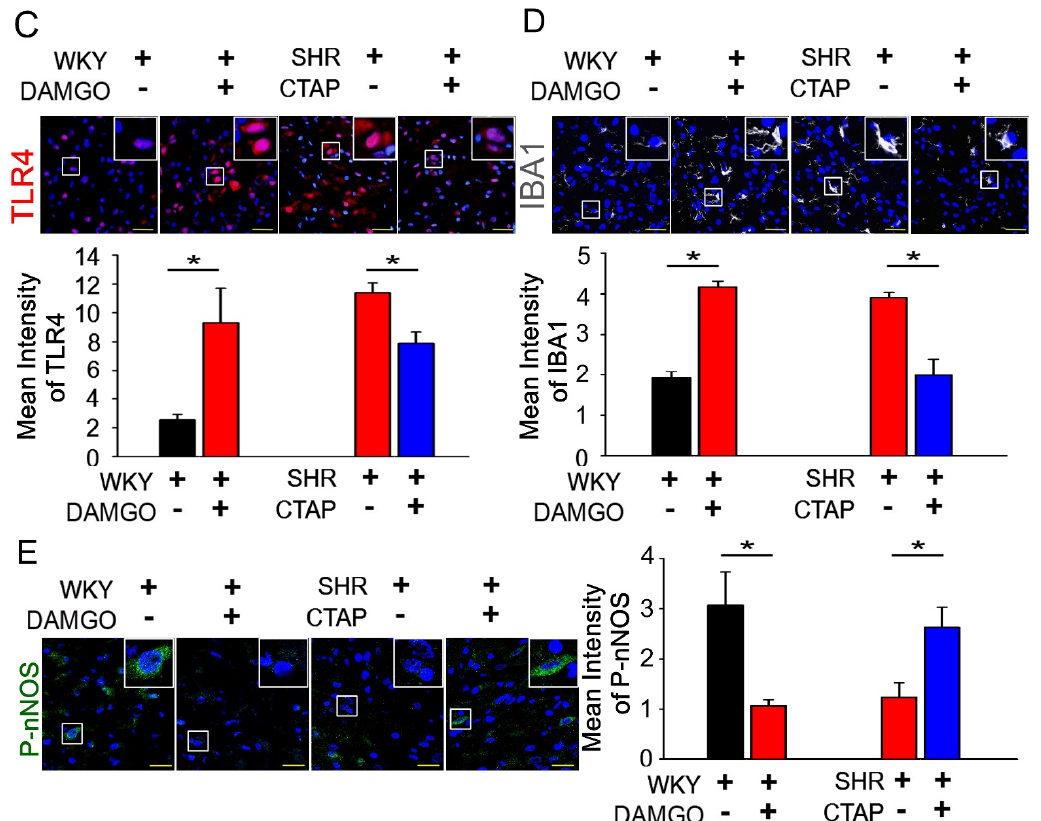
Figure 4. μ OR elevates the formation of AT1R and μ OR heterodimers, and induces the activation of microglia and the expression of TLR4 to impair the nNOS pathway in the NTS. ( A ) The in situ PLA (Proximity Ligation Assay) was used to confirm the formation of AT1R and µ OR ( µ -opioid receptors) heterodimers after intra-NTS DAMGO or CTAP microinjection. Green color indicates AT1R and µ OR heterodimers; the nuclei were counterstained with DAPI. The images were photographed at 1000 magnification. ( B – E ) Representative fluorescence images of AT1R (green), TLR4 (red) microglial marker IBA-1 (white) and nNOS S1416 (green)-positive cells after intra-NTS DAMGO or CTAP microinjection. The images were photographed at × 400 and 1000 magnification. The Mann–Whitney U-test was used for statistical analysis. Bar values are shown as mean ± SEM ( n = 6); * p < 0.05 versus